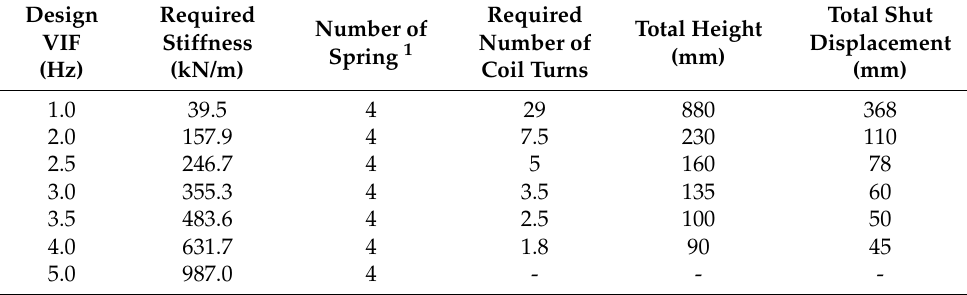
Table 7. Design summary of helical coil spring system with design VIF.